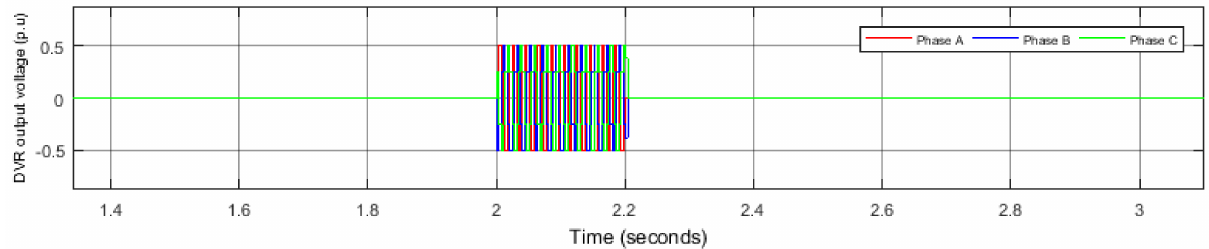
Figure 26. DVR compensation voltage for 3